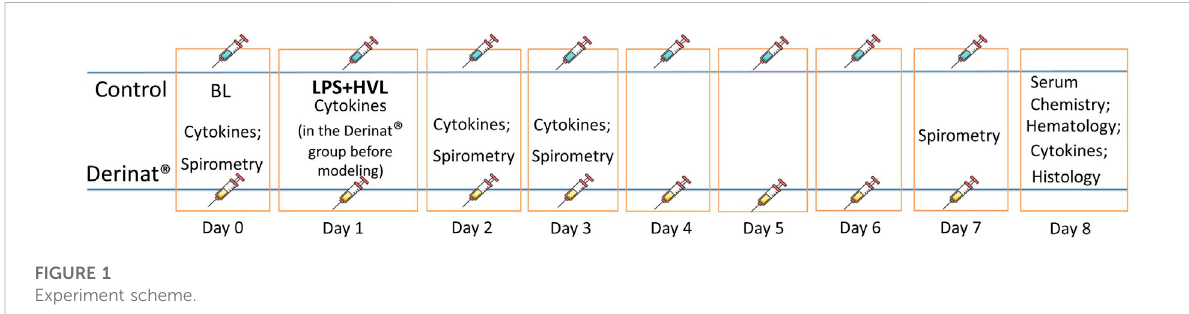
FIGURE 1 Experiment